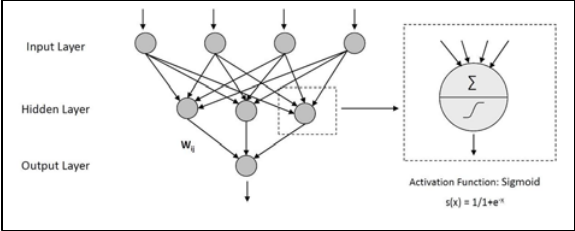
Figure 1. Scheme of a feed-forward artificial neural network